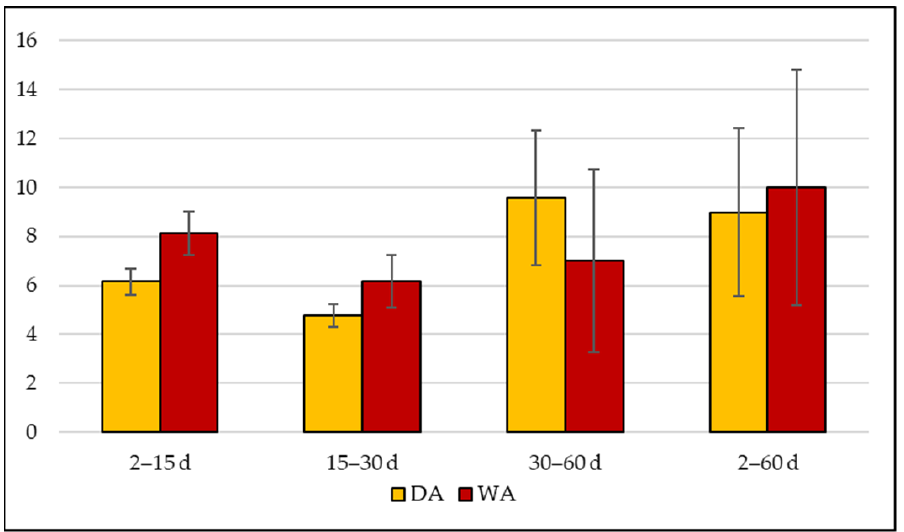
Figure 3. Variation of color ( ∆ E) during dry (DA) and wet (WA) aging in two Charolais meat cuts ( Longissimus dorsi (LD) and Semitendinosus (ST)) aging assessed between successive measurements (2 days and 15 days; 15 days and 30 days; 30 days and 60 days; 2 days and 60